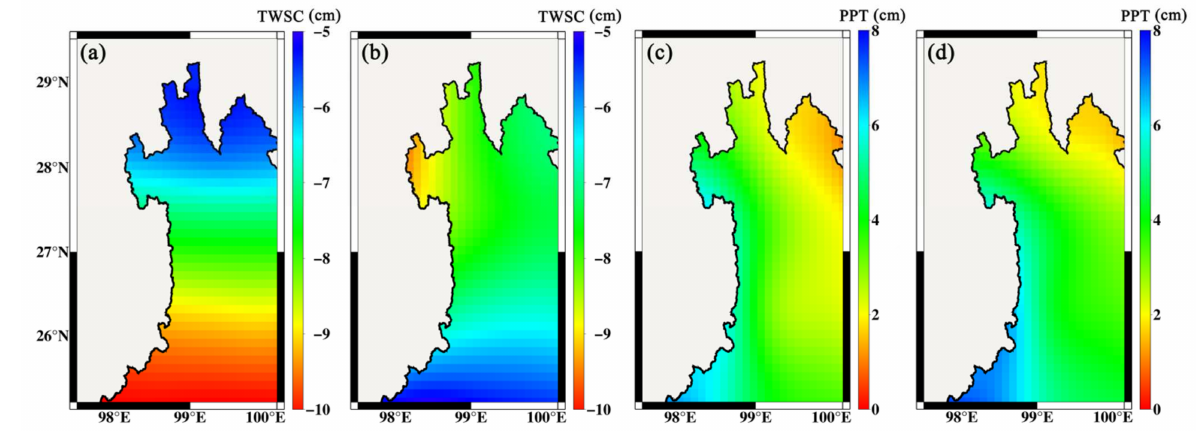
Figure 13. The spatial distribution of GRACE TWSC and PPT for the differences between high- and low-fire years in region NW. The monthly average GRACE TWSC in high- and low-fire years ( a , b ) and the monthly average PPT ( c , d ).